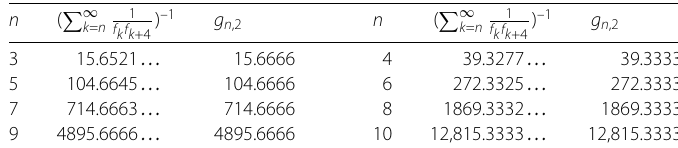
Table 2 Some values of (